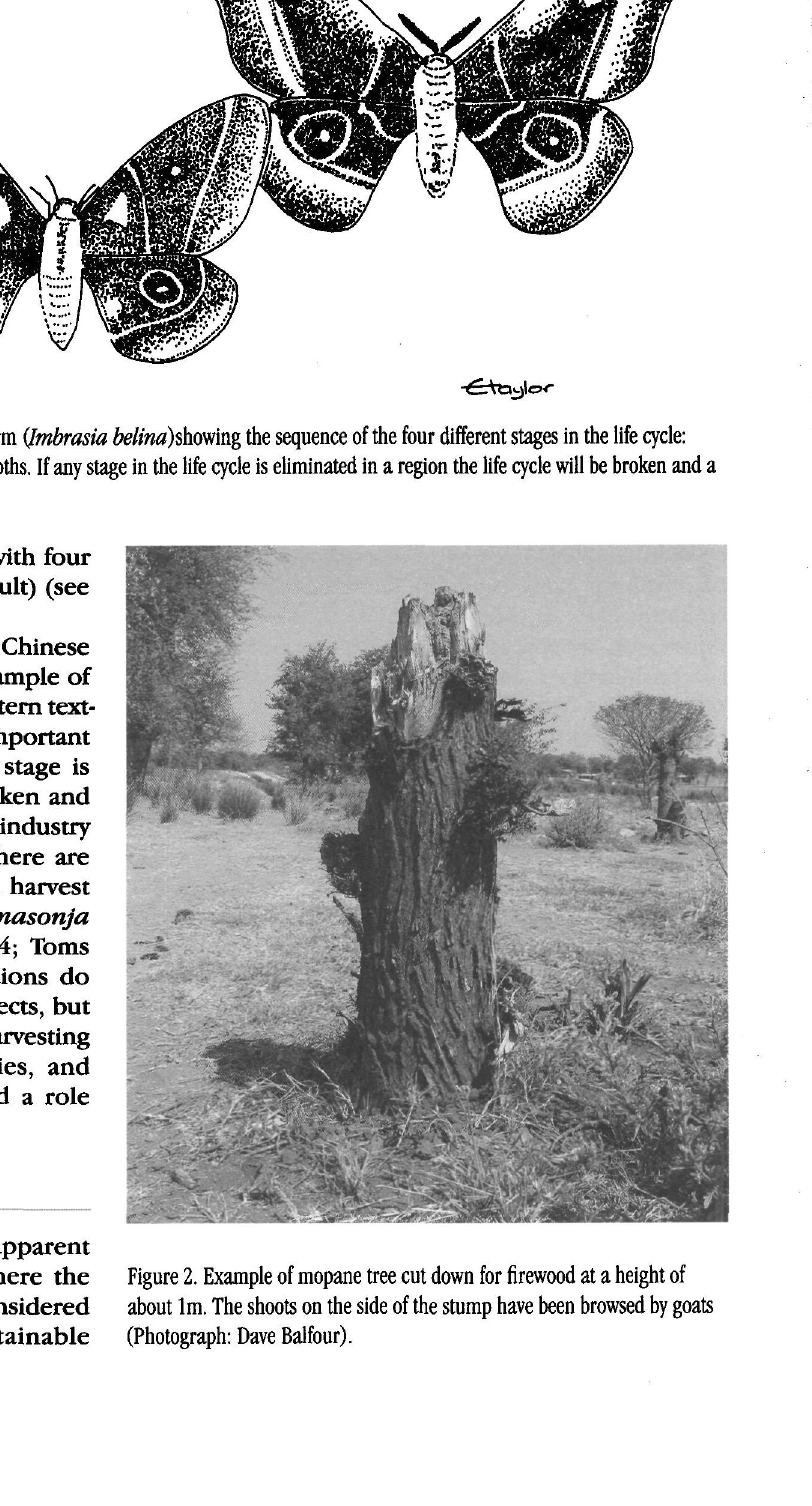
Figure 2. Example of mopane tree cut down for firewood at a height of about lm. The shoots on the side of the stump have been browsed by goats (Photograph: Dave